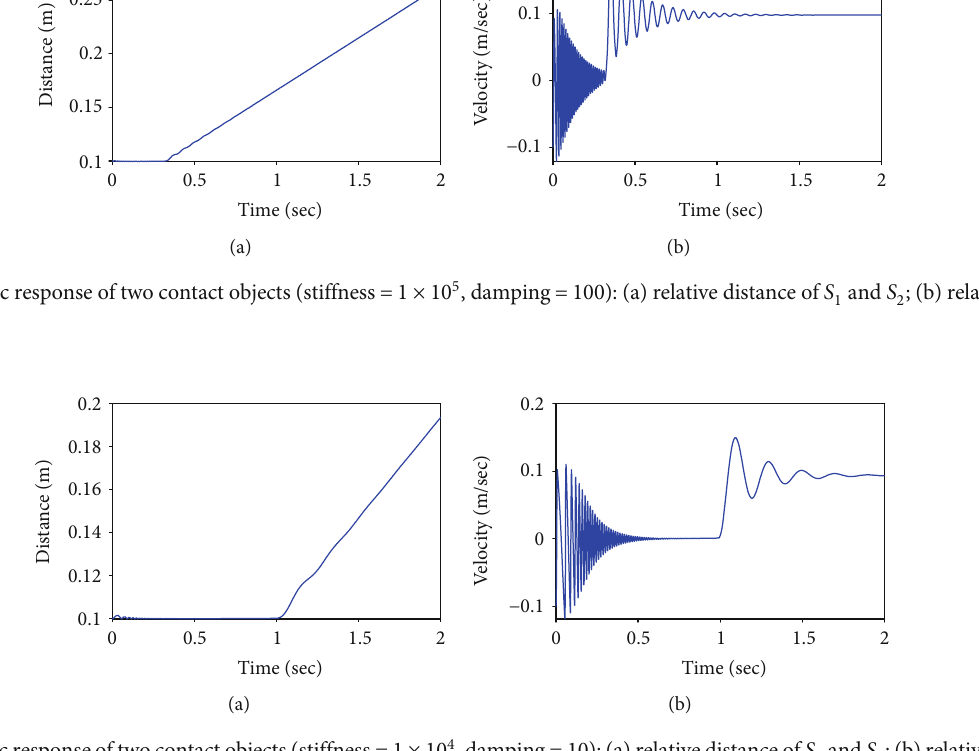
and S ; (b) relative velocity of 1 2